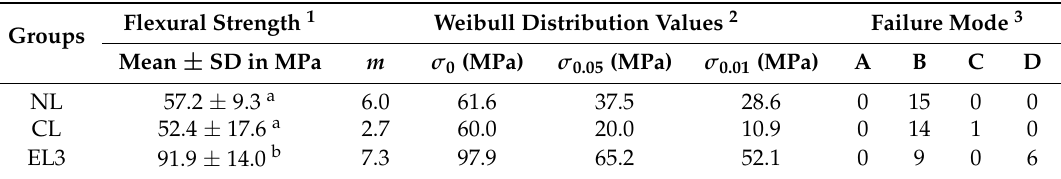
Table 4. Flexural strength, Weibull distribution values, and failure mode distribution for each group ( n = 15).